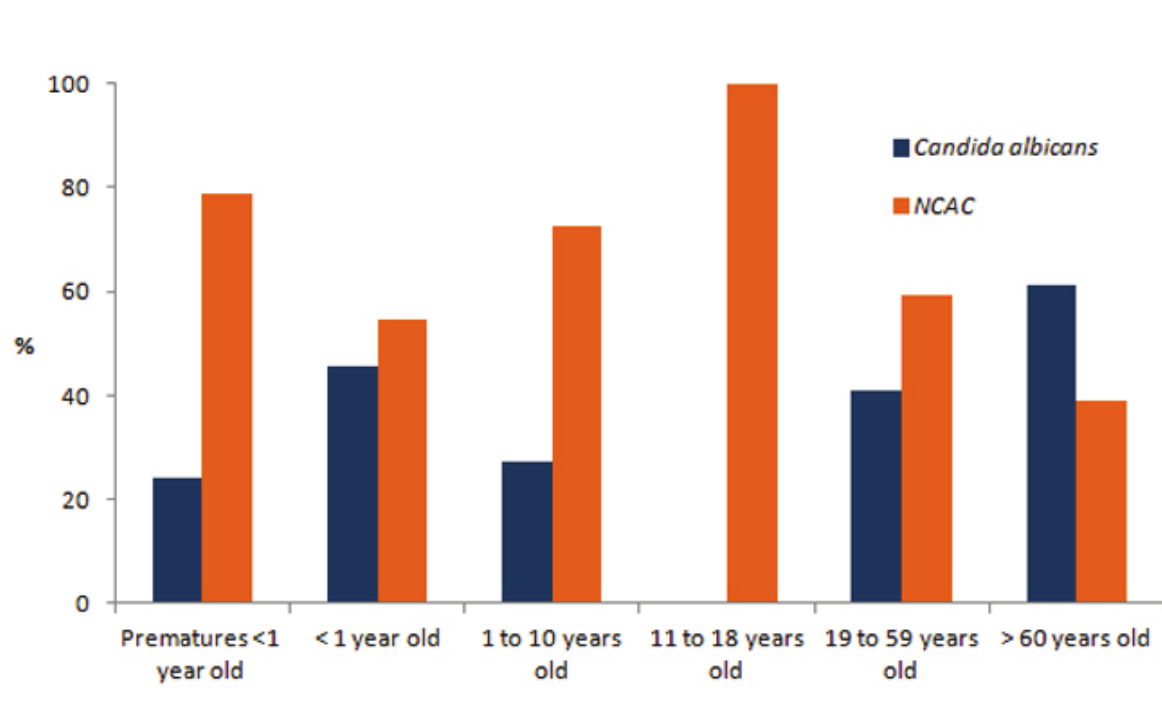
Figure 1. Percentage of Candida albicans and other Candida species by age.